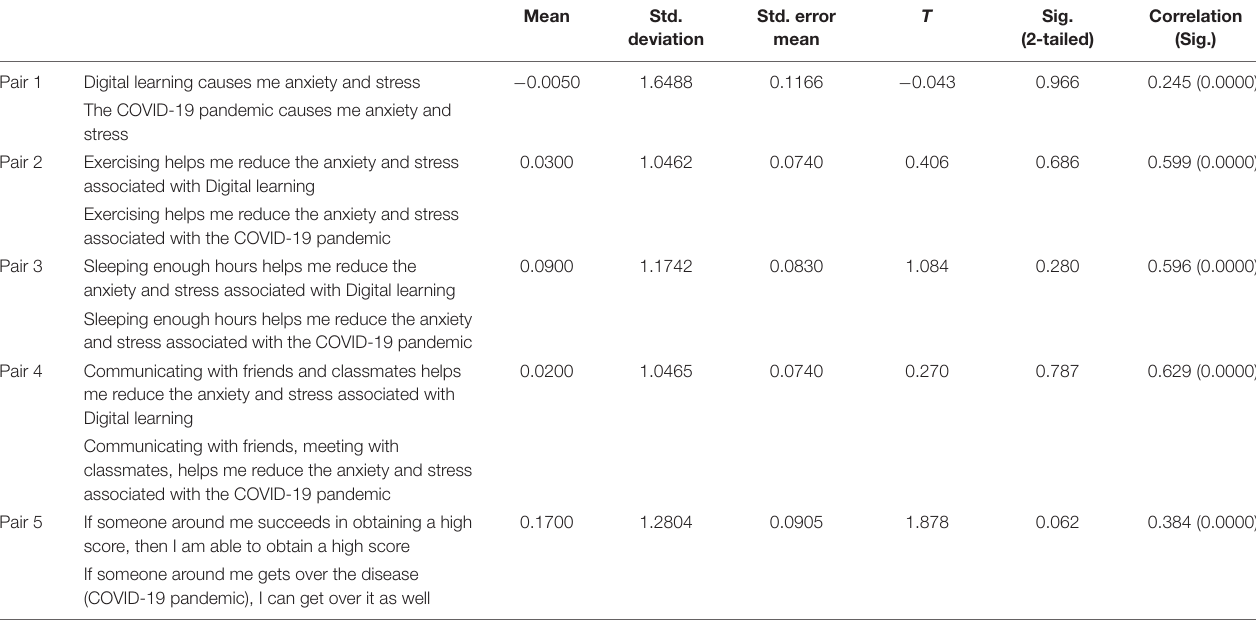
TABLE 5 | Paired samples test and correlations (Section 2: Digital learning in time of COVID-19, stress, psychological effects and its role in defense mechanisms and coping strategies).